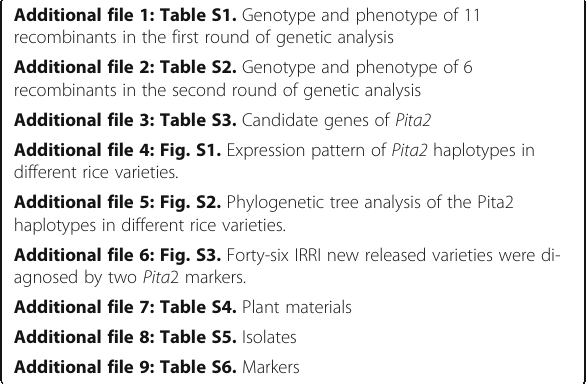
Additional file 3: Table S3. Candidate genes of